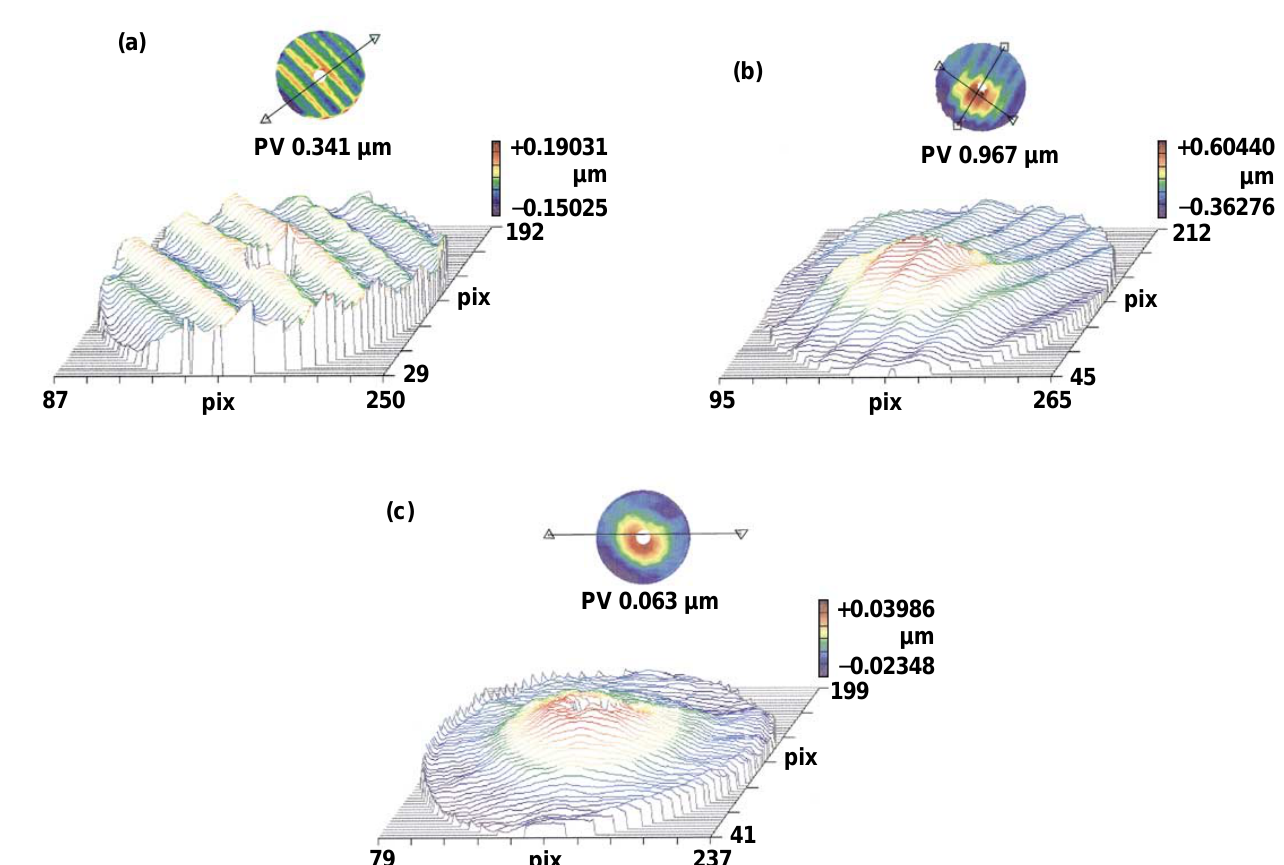
FIG. 5. (Color) Inspection records of the two diamond-machined surfaces. (a) Surface produced by diamond fly cutting of an unannealed part. Note the waviness of the surface. (b) Surface produced by postannealing a diamond fly-cut part. Note the deformation due to stress relief around the center hole. (c) Surface produced by diamond turning of an annealed surface. The flatness is less than 100